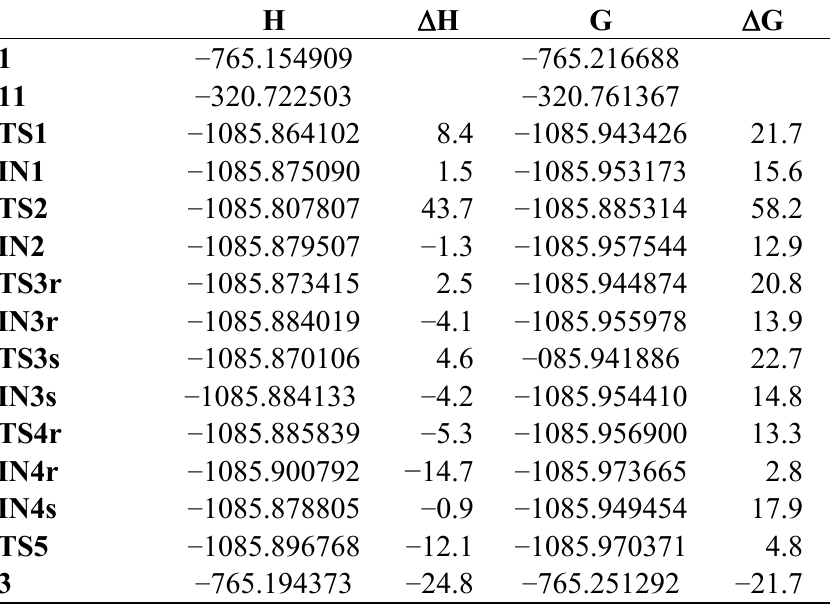
Table 1. Total (H and G, in au) and relative (  H and  G, in kcal/mol) enthalpies and free energies, computed at 25 °C and 1 atm in toluene, of the stationary points involved in the intramolecular Stetter reaction of salicylaldehyde 1 .